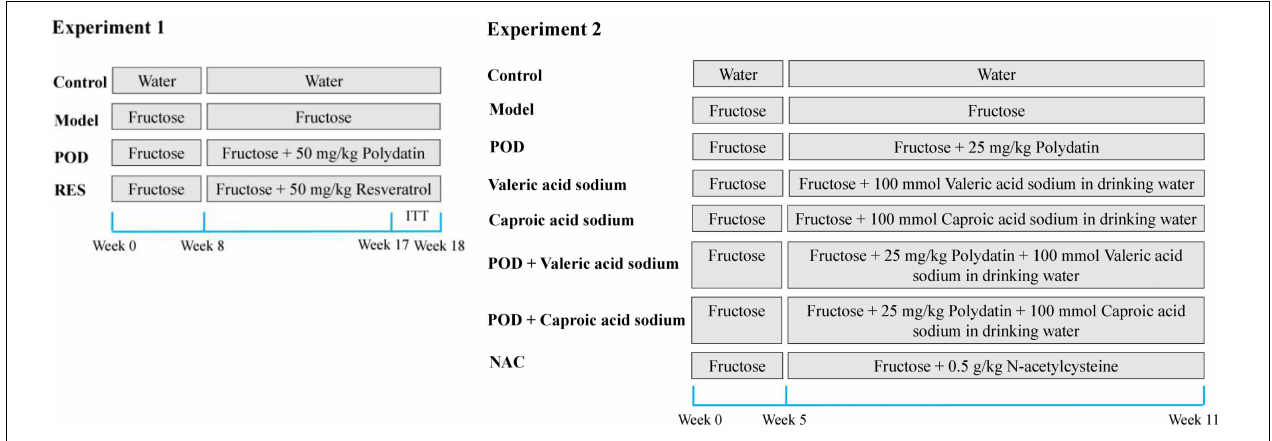
FIGURE 2 | Experimental design for drug